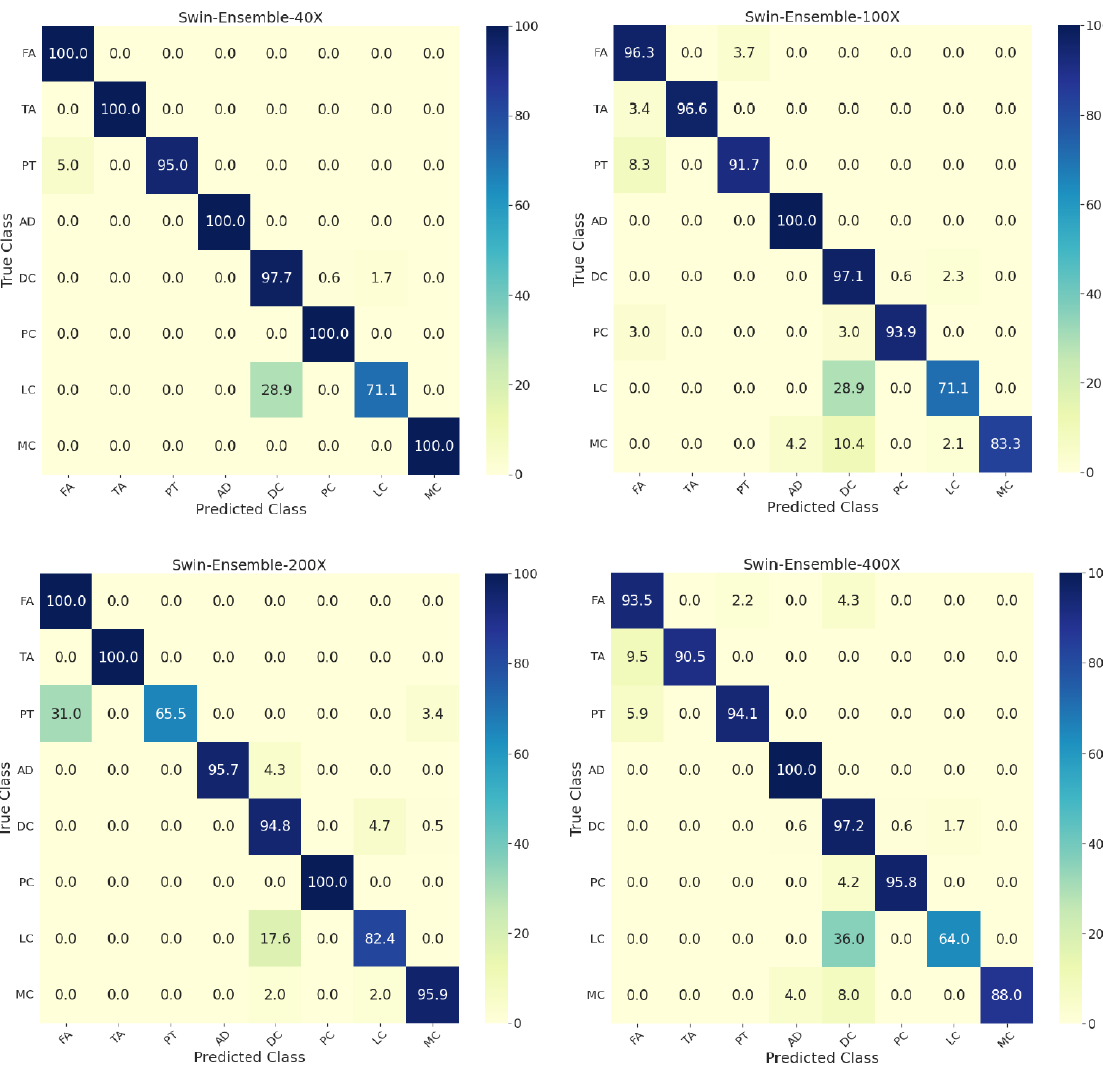
Figure 5. Confusion matrices on the test set for the eight-class classification of benign and malignant subtypes for the ensemble of swin transformers at 40×, 100×, 200×, and 400× zoom factors. T: tiny, S: small, B: base, L: large. FA: fibroadenoma, TA: tubular adenoma, PT: phyllodes tumor, AD: adeno- sis, DC: ductal carcinoma, PC: papillary carcinoma, LC: lobular carcinoma, MC: mucinous carci-